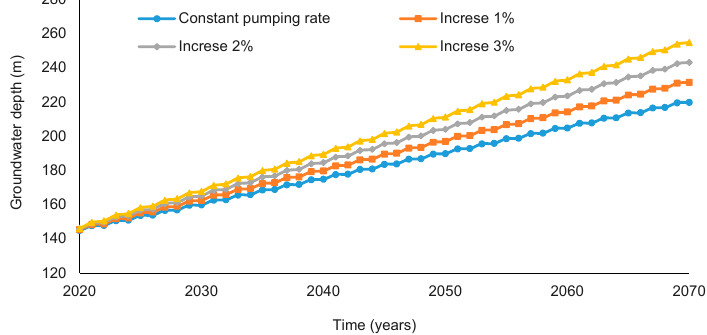
Figure 13. Future prediction results of groundwater depths / aquifer depletion for various pumping rate scenarios.